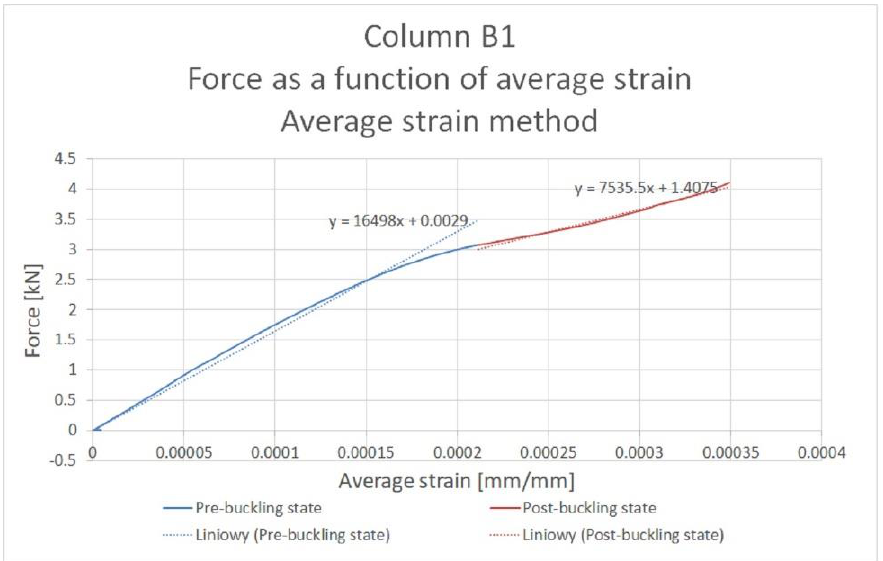
Figure 6. Procedure for determining the critical force by the strain average method using the example of column B1.